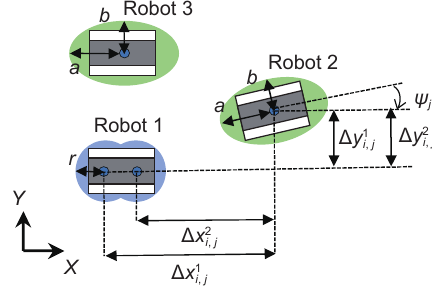
Fig. 3 Multi-robot movement schematic (from the perspective of Robot 1, dynamic obstacles are Robot 2 and Robot